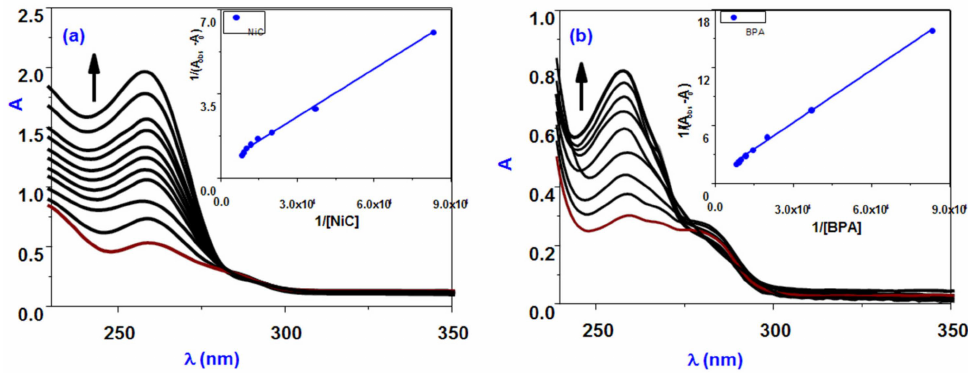
Figure 4. UV-absorption spectra of BSA in the absence and presence of increasing amounts of ( a ) NiBPA and ( b ) BPA in phosphate buffer (inset are Benesi–Hildebrand